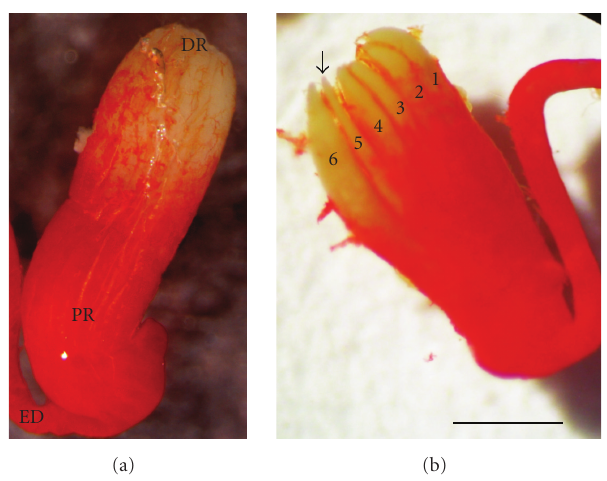
Figure 1: Testis of Euschistus heros enclosed by red membrane, where the proximal region (PR) of the ejaculatory duct (ED) is more intense red than the Distal Region (DR) (a). Observe in (b) the presence of six elongated lobes of approximately the same length, with lobe 5 narrower than the others (arrow). Bar =